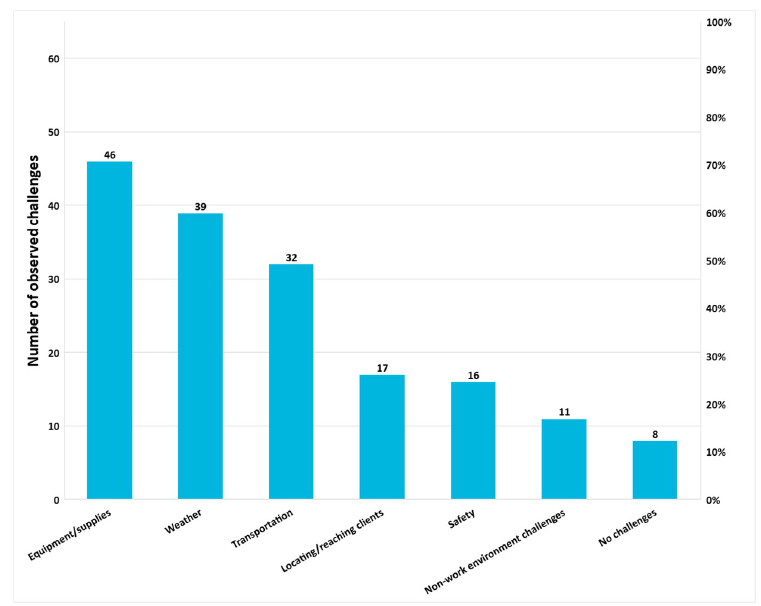
Fig 5. Observed work environment challenges for outreach teams, n = 65 field-based observations. � Categorization of observation challenges, other than ‘no challenges’, is not mutually exclusive.